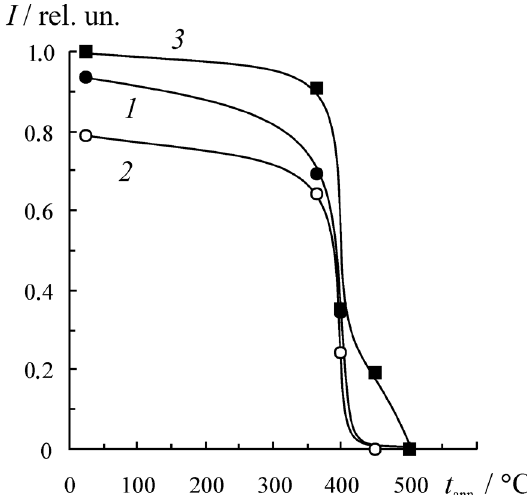
Figure 6. The change in the relative intensity of the marcasite reflexes after the 36-hours annealing of pyrite-marcasite mixtures: 1 ‒ 100; 2 ‒ 120; 3 ‒ to Table 1. Pyrite-phase volume fractions in the pyrite-marcasite mixtures after the 36 h-annealing of the native pyrite-marcasite samples under the KCl ‒ FeCl eutectic melt 2 t , ºC annealing